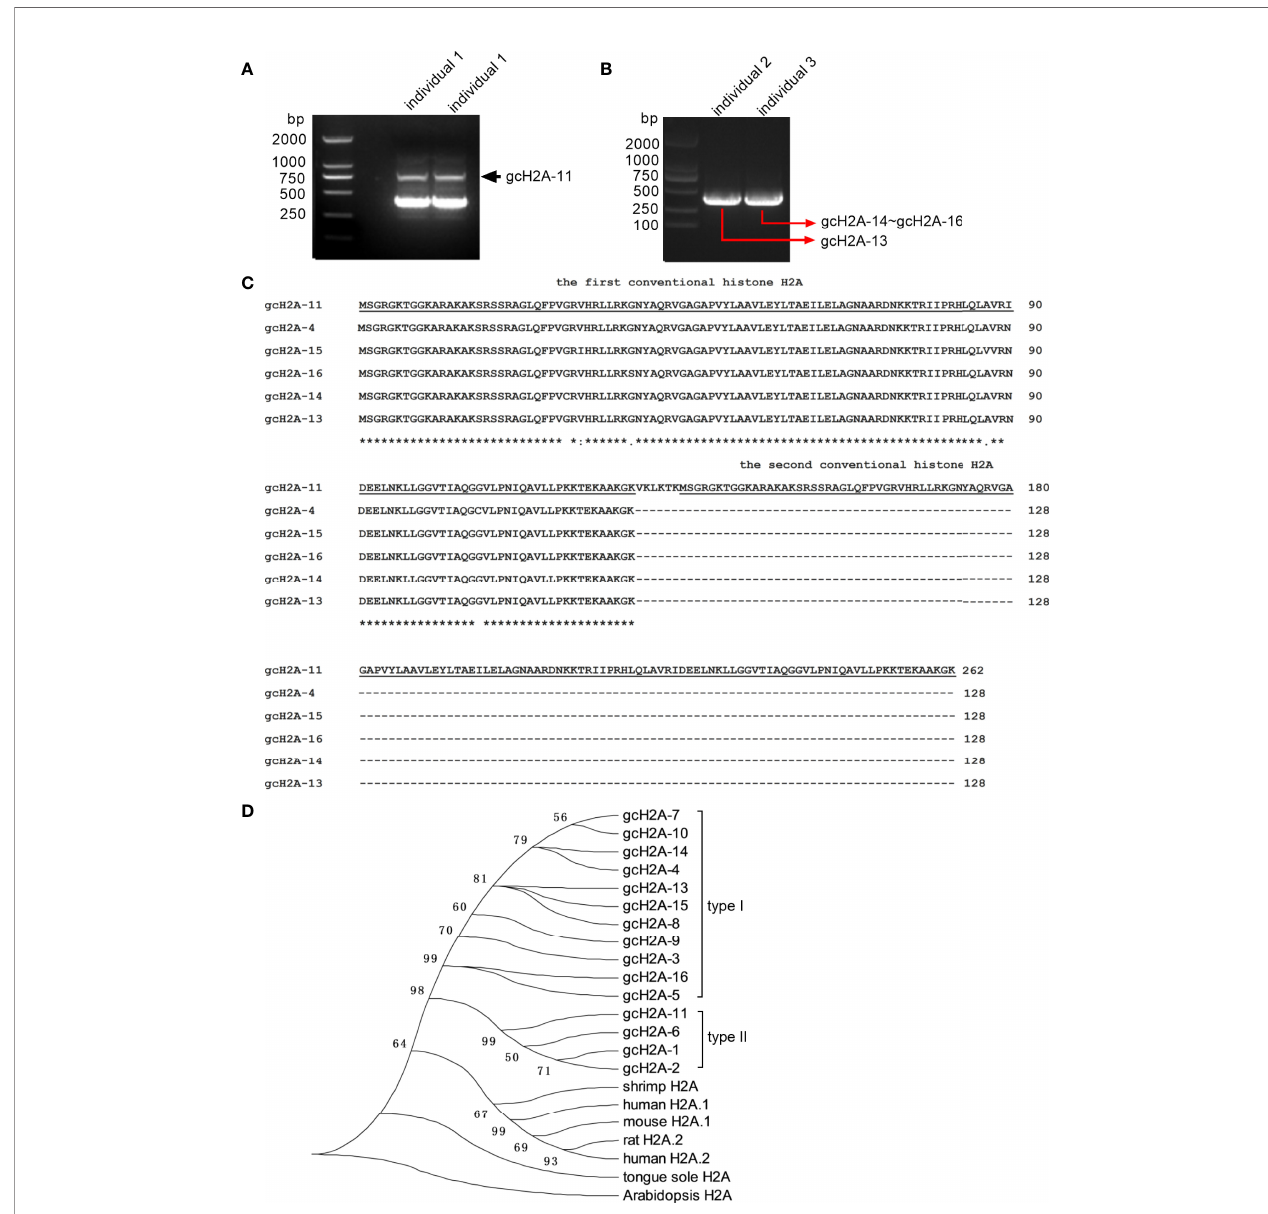
FIGURE 1 | The cloning and sequence analysis of grass carp histone H2A variants. (A) The cloning of gcH2A-11 from the gills of grass carp individual 1 infected with F. columnare . (B) The cloning of gcH2A-13 and gcH2A-14~16 from the gills of grass carp individual 2 and 3 infected with F. columnare , respectively. (C) Sequence alignments of gcH2A-4, gcH2A-11 and gcH2A-13~16. The conventional histone H2A region is underlined. (D) Phylogenetic analysis of grass carp histone H2A variants, and histone H2A from other species including shrimp H2A (GenBank accession number: XM_037921631), human H2A.1 (GenBank accession number: M60752), mouse H2A.1 (GenBank accession number: M33988), rat H2A.2 (GenBank accession number: JX661509), human H2A.2 (GenBank accession number: L19779), tongue sole H2A (GenBank accession number: KU904500) and Arabidopsis H2A (GenBank accession number: